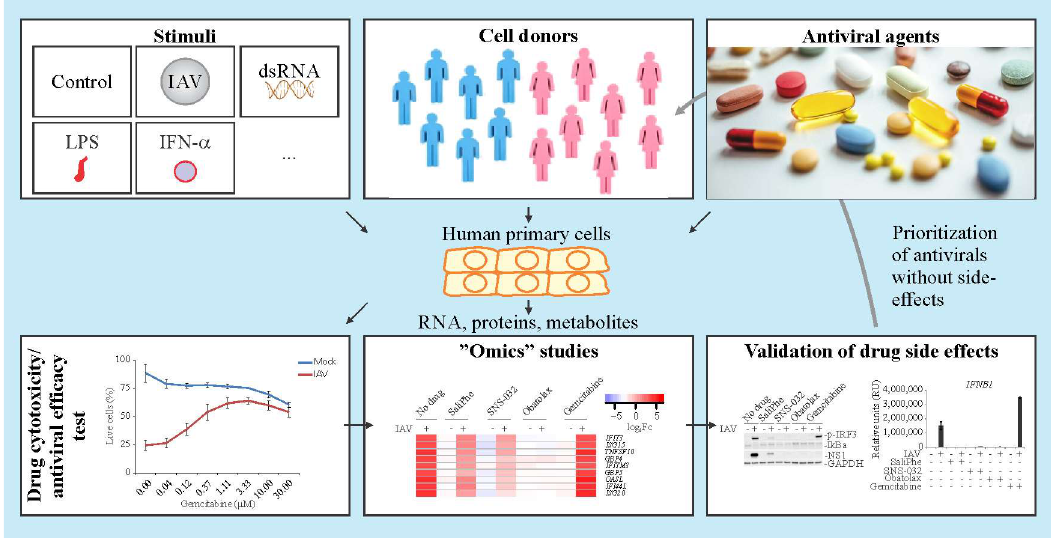
Figure 2. Systems approach to study immuno- and neuro-modulatory properties of antiviral agents.